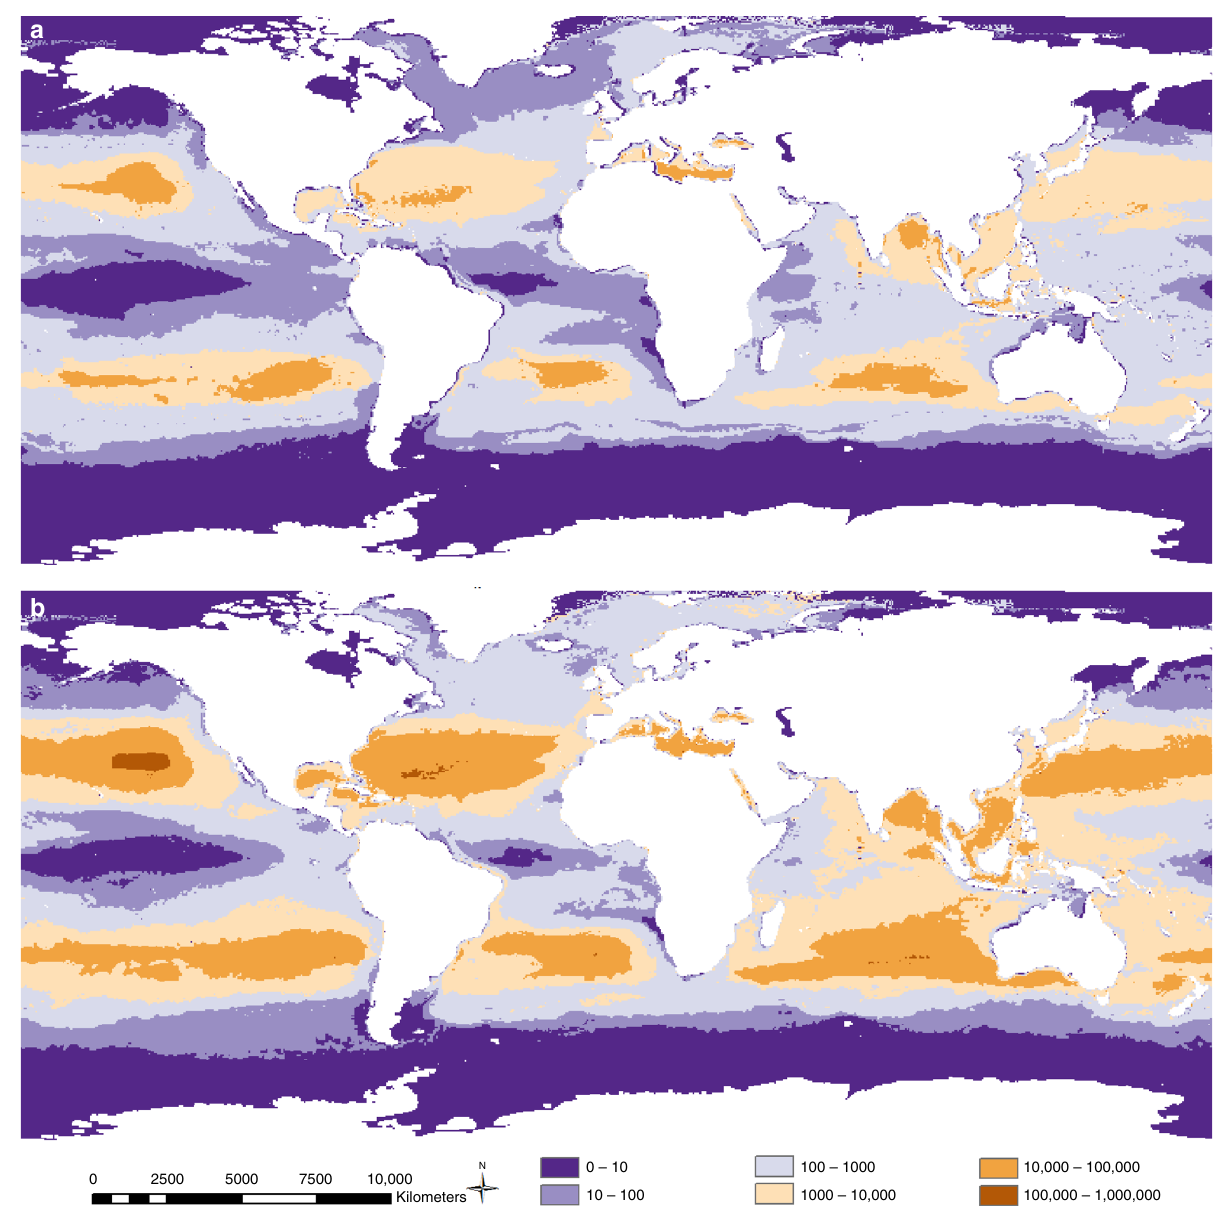
Fig. 4 Global risk of plastic entering zooplankton communities. a Using the animal-plastic size relationship to estimate the density of ingestible plastics (0.33 – 1.00 mm in length) divided by zooplankton density. b Current ‘ state of the art ’ : as for a , with ingestible plastic densities substituted with total plastic densities. Legend coarsely estimates the level of plastic ingestion risk for